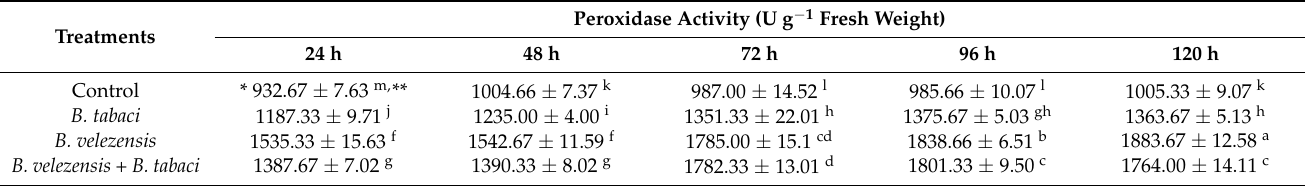
Table 4. The time-course of peroxidase activity in squash plants exposed to Bemisia tabaci and Bacillus velezensis , and both agents compared with